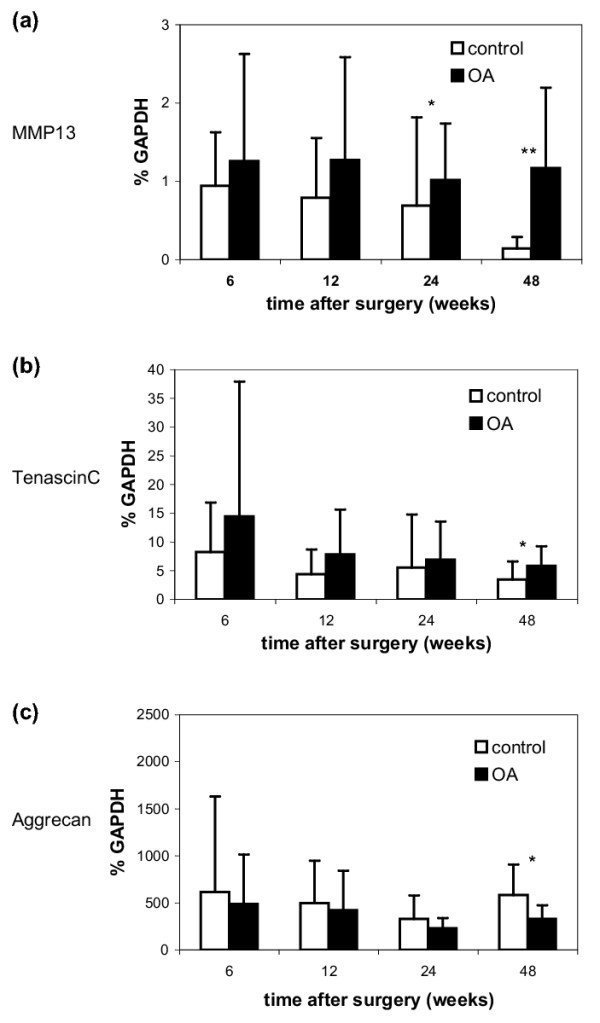
(a) MMP13, (b) tenascinC and (c) aggrecan expression in cartilage of experimental osteoarthritis (OA) at different times after surgery. Shown are the mean relative expression levels of mRNA summarized for lateral and medial tibial plateau. * P < 0.05, ** P < 0.001.